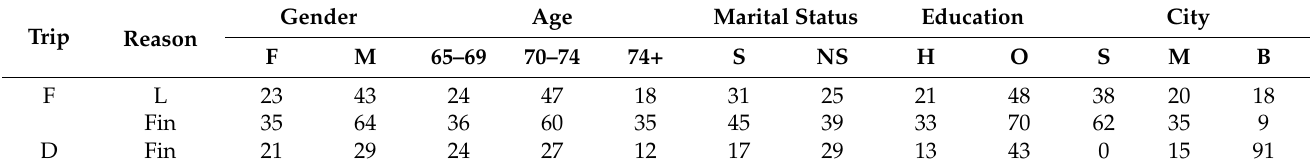
Table 3. Reasons for resigning from tourism